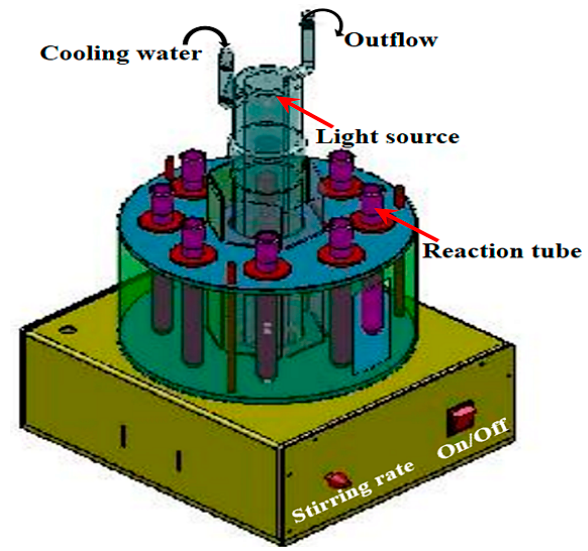
Figure 13. Diagrammatic sketch of the photocatalytic disinfection reactor system.